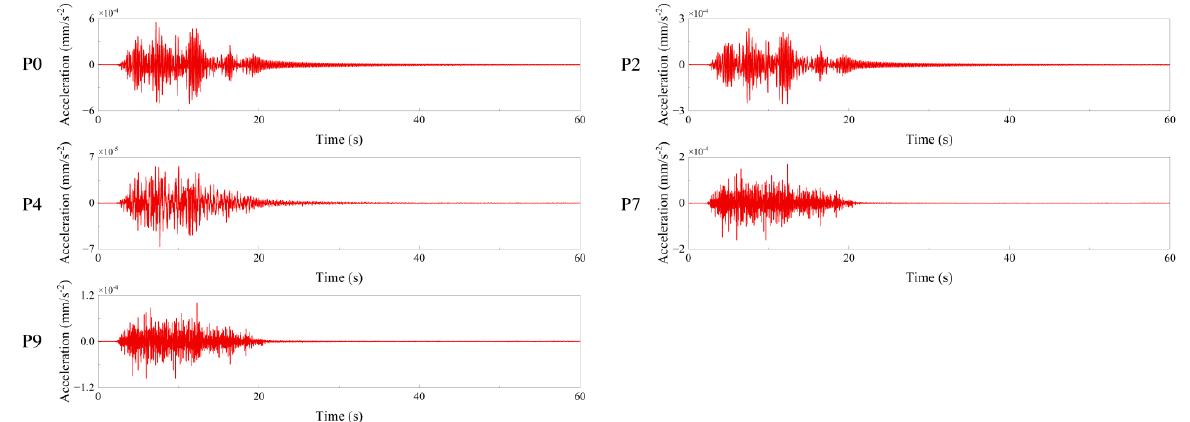
Figure 24. Accelerometers monitoring wind turbine structural responses.